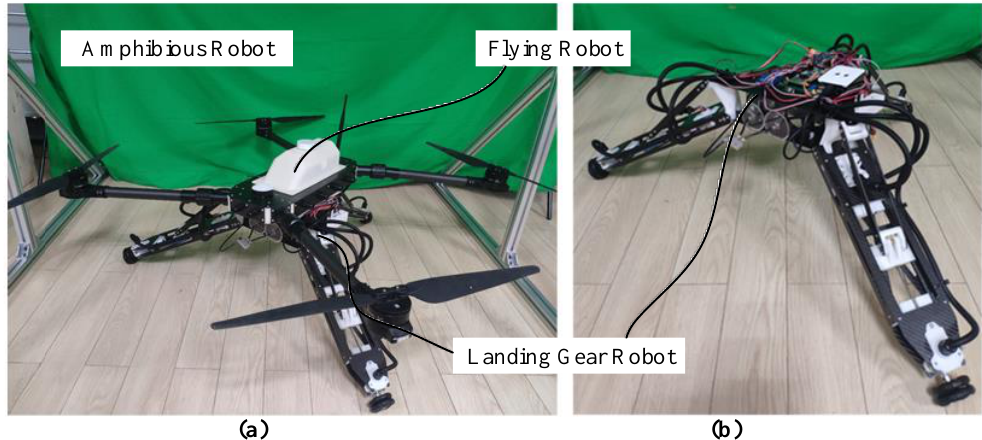
Figure 1. ( a ) The amphibious robot and ( b ) landing gear robot.